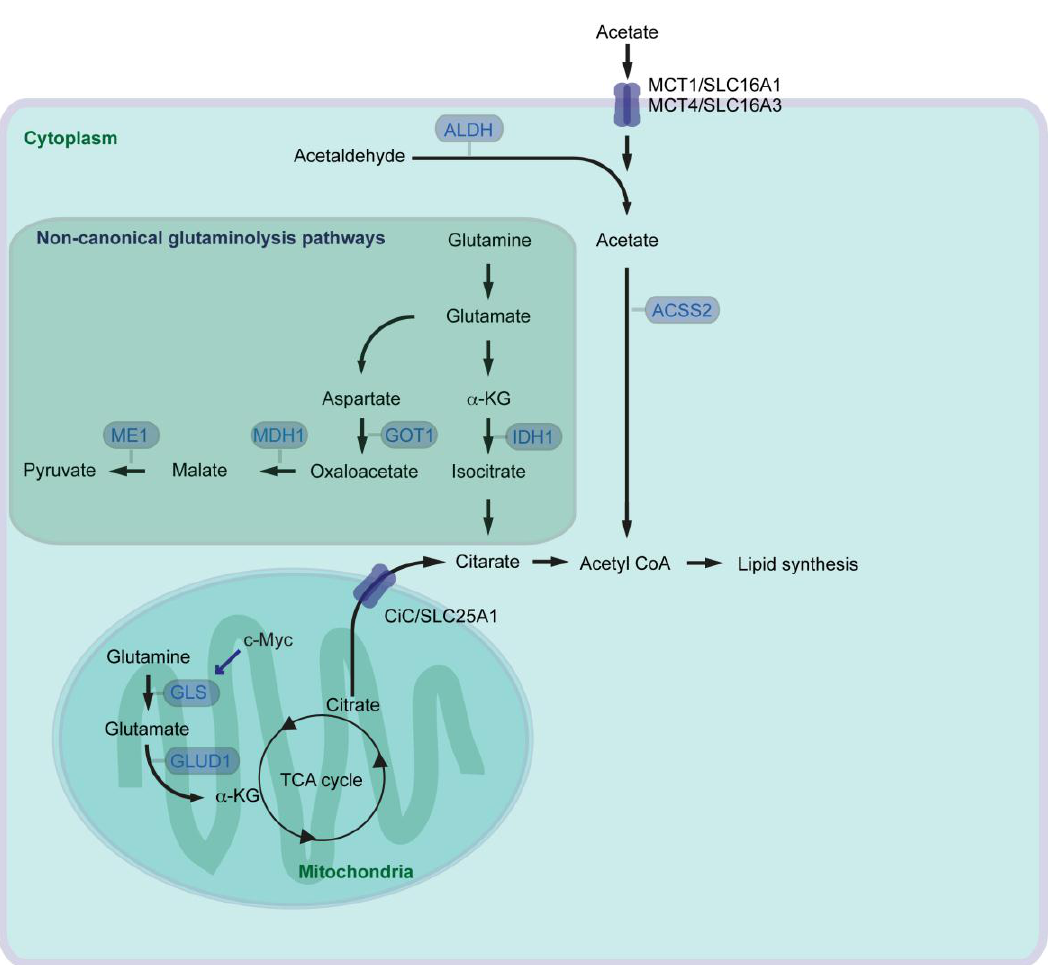
Figure 2. Canonical as well as non-canonical glutaminolysis pathways, and acetate pathway for supporting lipid metabolism in cancer (ACSS: acyl-CoA synthetase short chain family member; ALDH: Aldehyde dehydrogenase; CiC: citrate carrier; GLS: glutaminase; GLUD: glutamate dehydrogenase; GOT: aspartate transaminase; α-KG: α-ketoglutarate; IDH: isocitrate dehydrogenase; MCT: monocarboxylate transporter; MDH: malate dehydrogenase; ME: malate enzyme; SLC: solute carrier; TCA: tricarboxylic acid cycle).